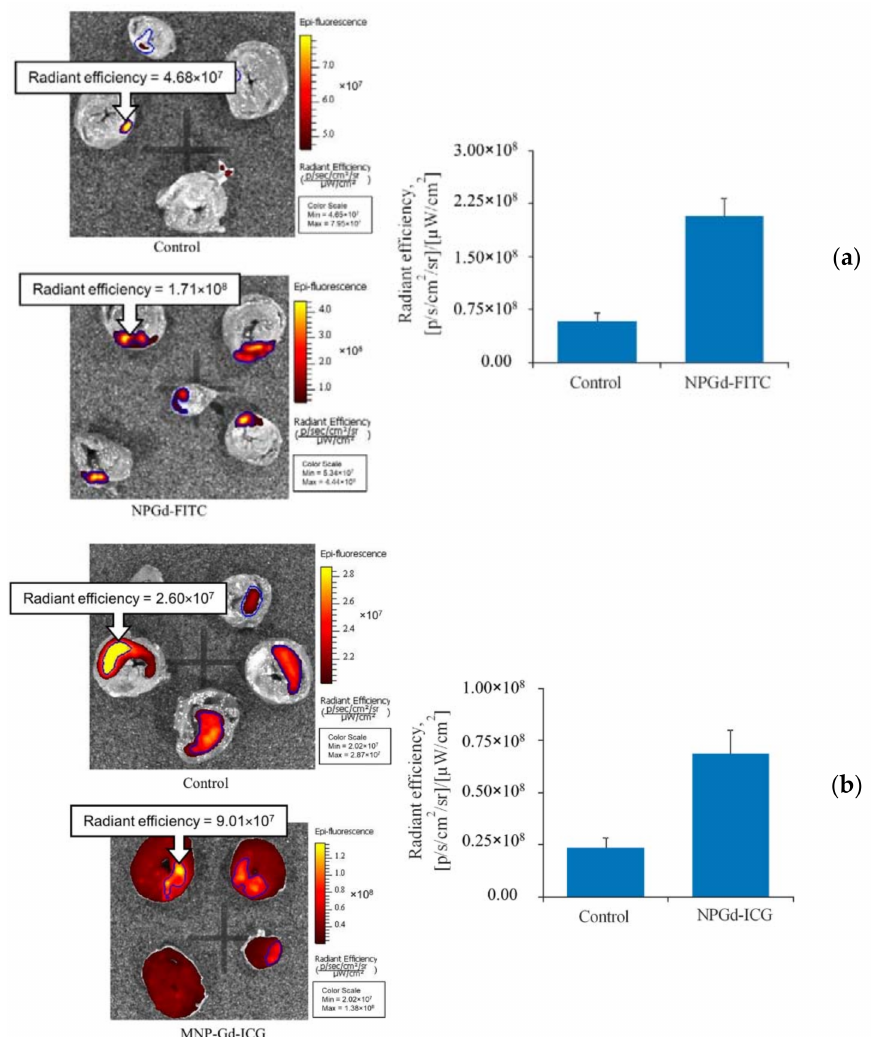
Figure 10. Heart targeting by GF/TPO NPs in the setting of ischemia–reperfusion injury. The animals were randomized into three groups: (1) controls ( n = 5) received i.v. infusion of saline, (2)